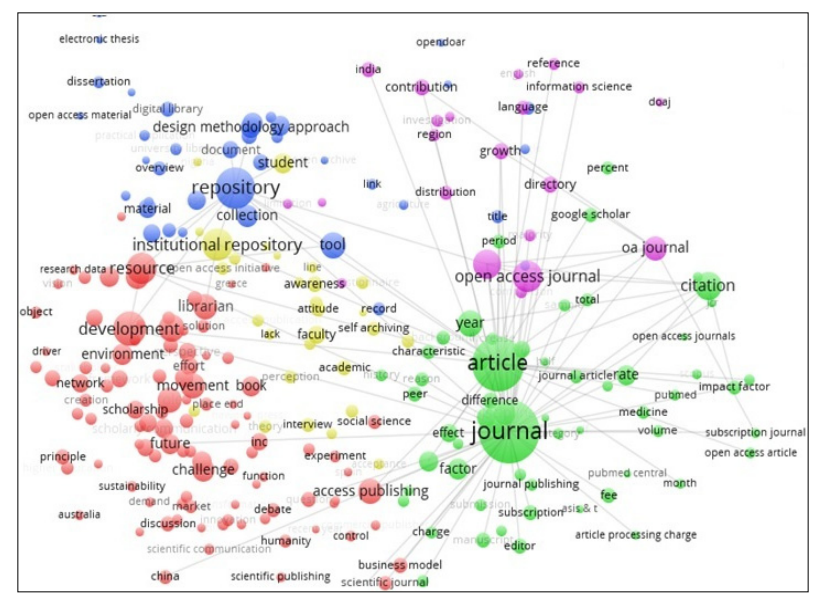
Figure 3. Net of the co-occurrence of words in titles and